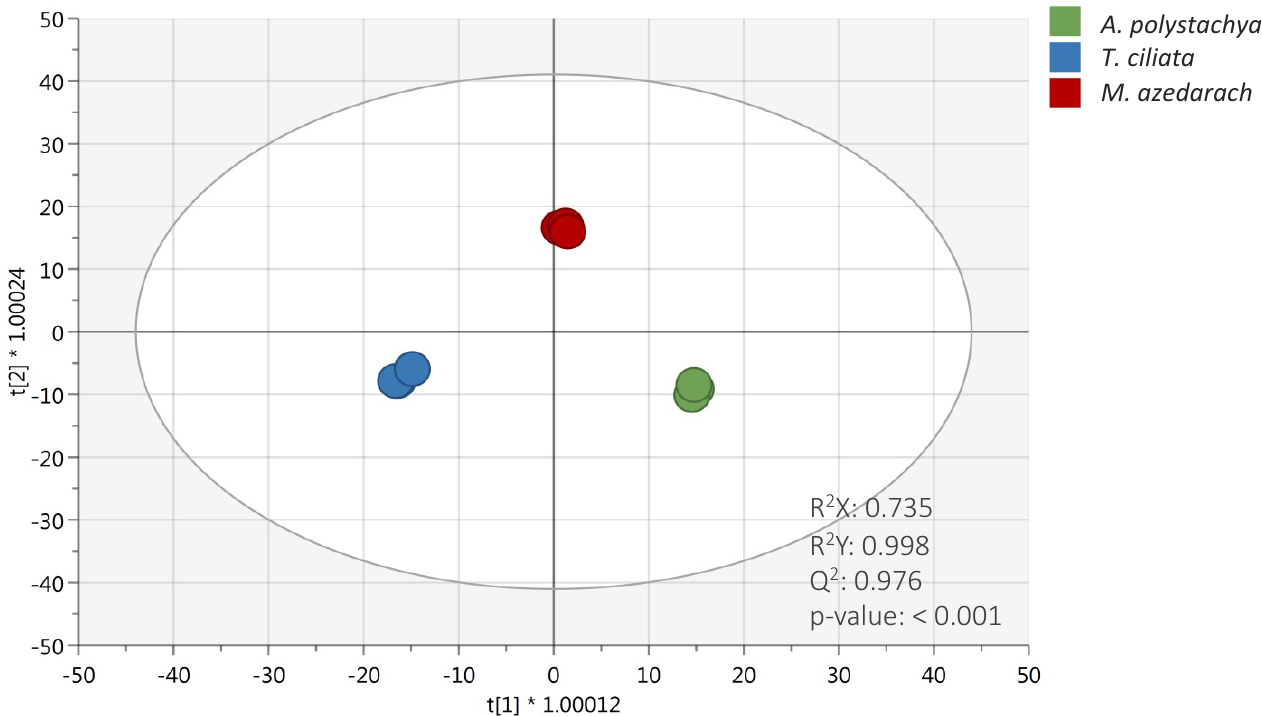
Figure 1. OPLS-DA score plot considering the different extracts of Meliaceae species under investigation. The accuracy parameters of the prediction model are also provided in the score plot.